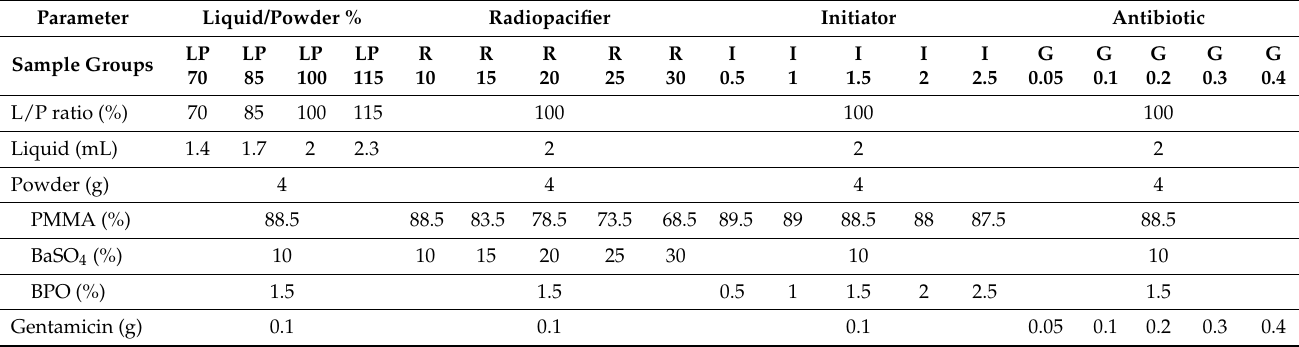
Table 2. Composition of tested PMMA bone cements with different